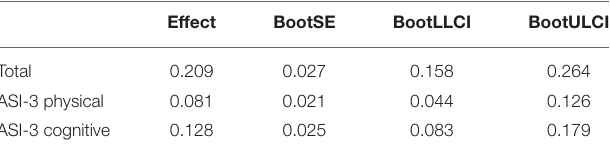
TABLE 2 | Regression analysis of variable relationships in models. Outcome variable